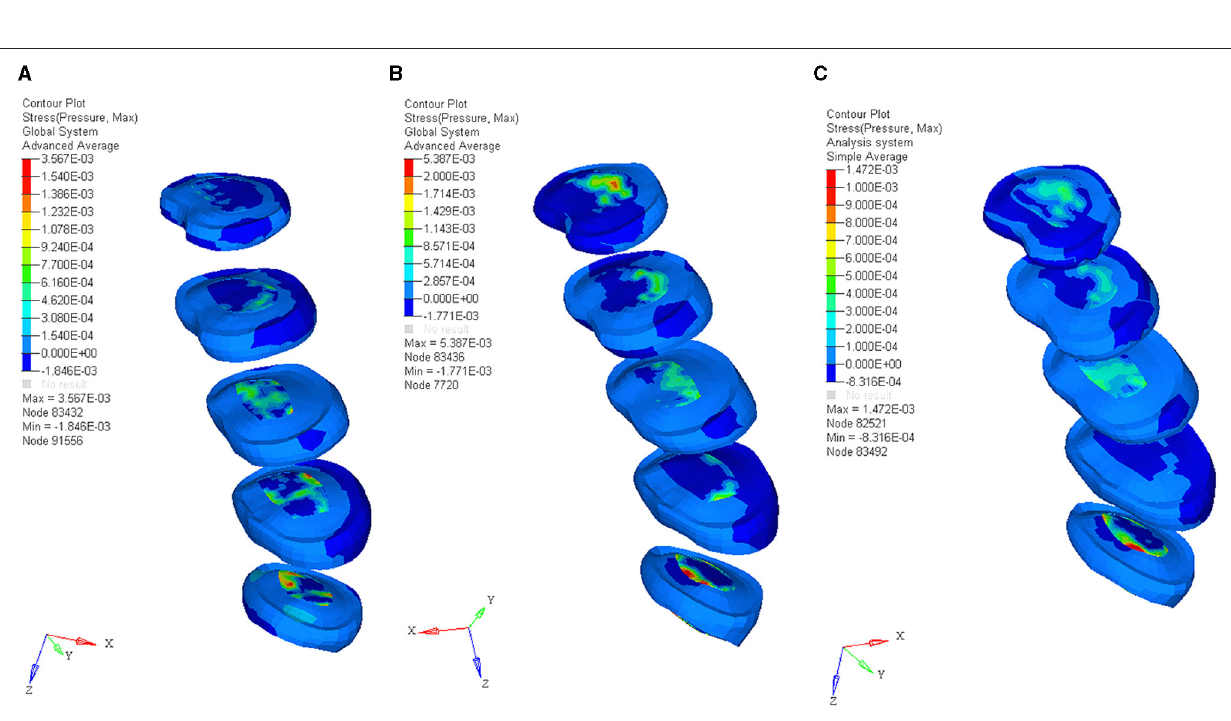
failure vs. and the stress curve, the cycle to failure of lumbar vertebrae spongy bone in three different postures were shown in Table 1